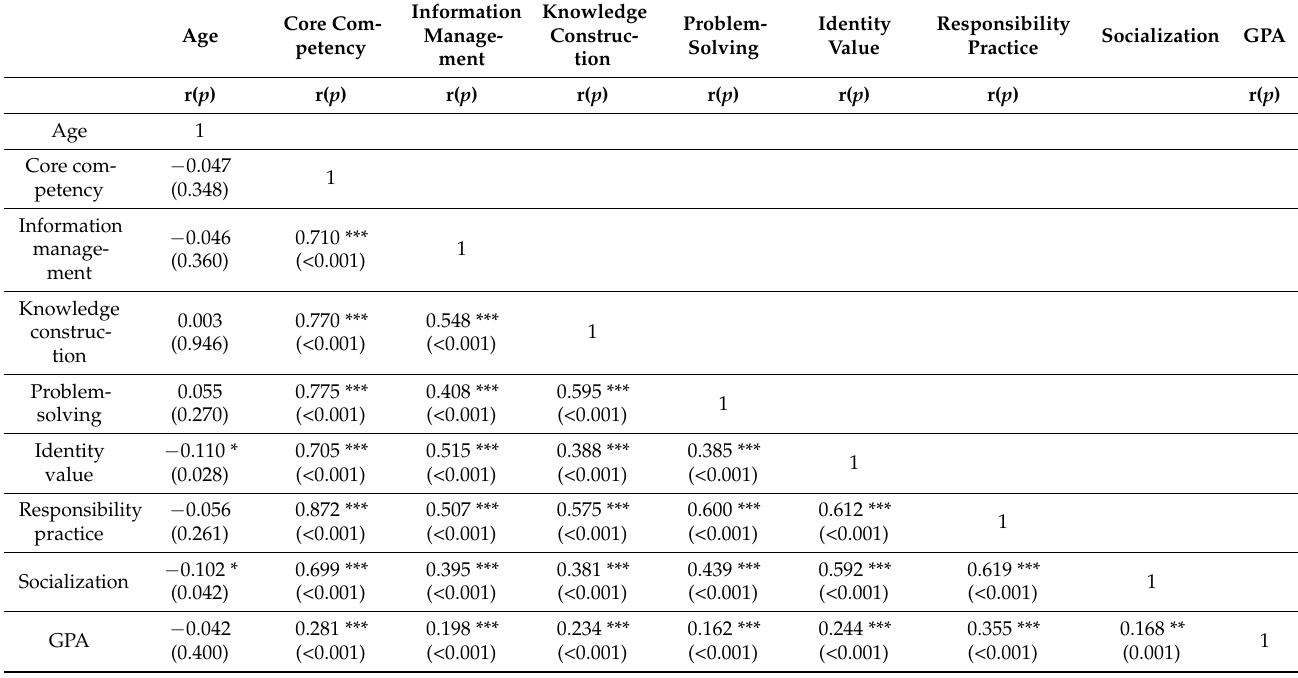
Table 3. Correlation among participant characteristics, core competencies, and academic